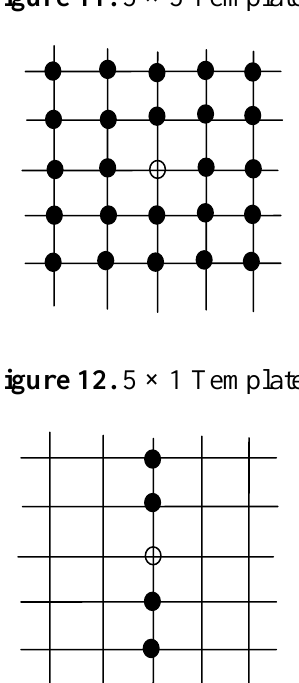
Figure 11. 5 × 5 Template.